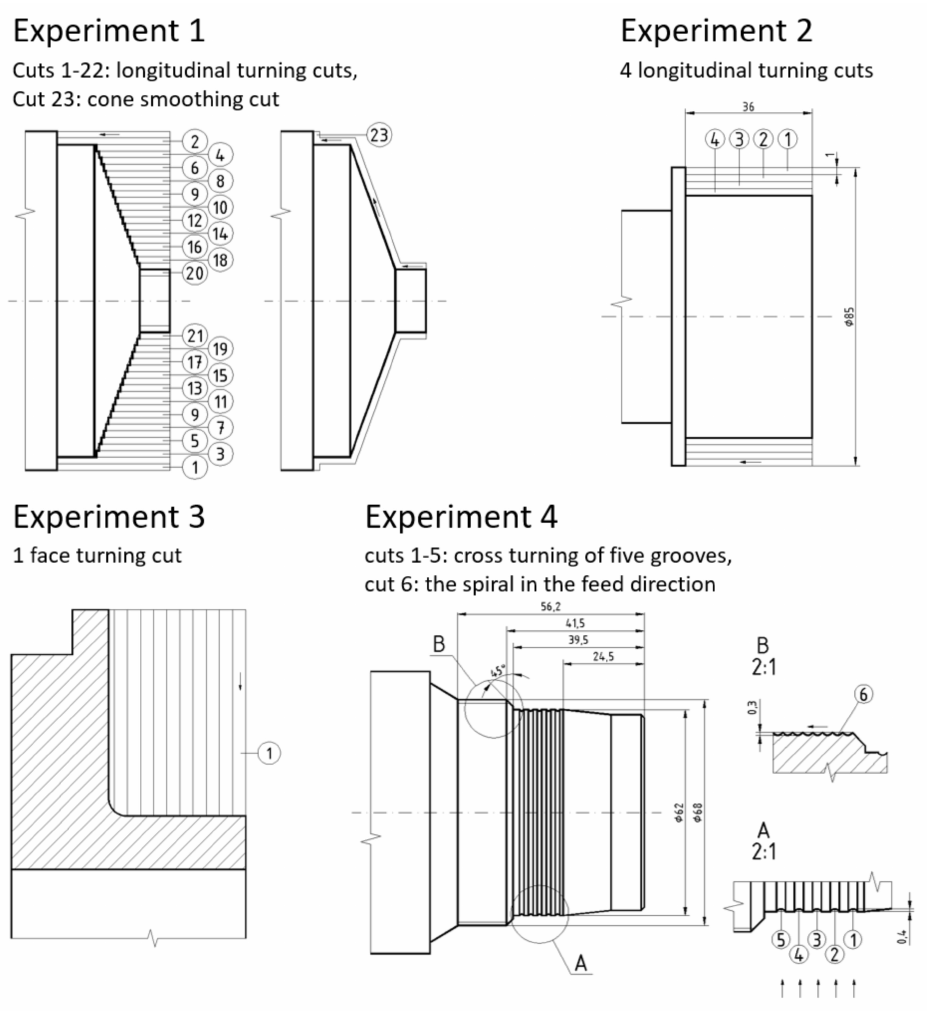
Figure 4. Machining patterns in Experiments